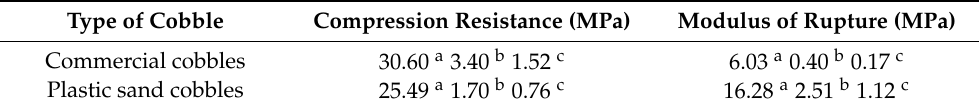
Table 2. Compression Modulus of rupture of commercial and plastic sand cobbles. Type of